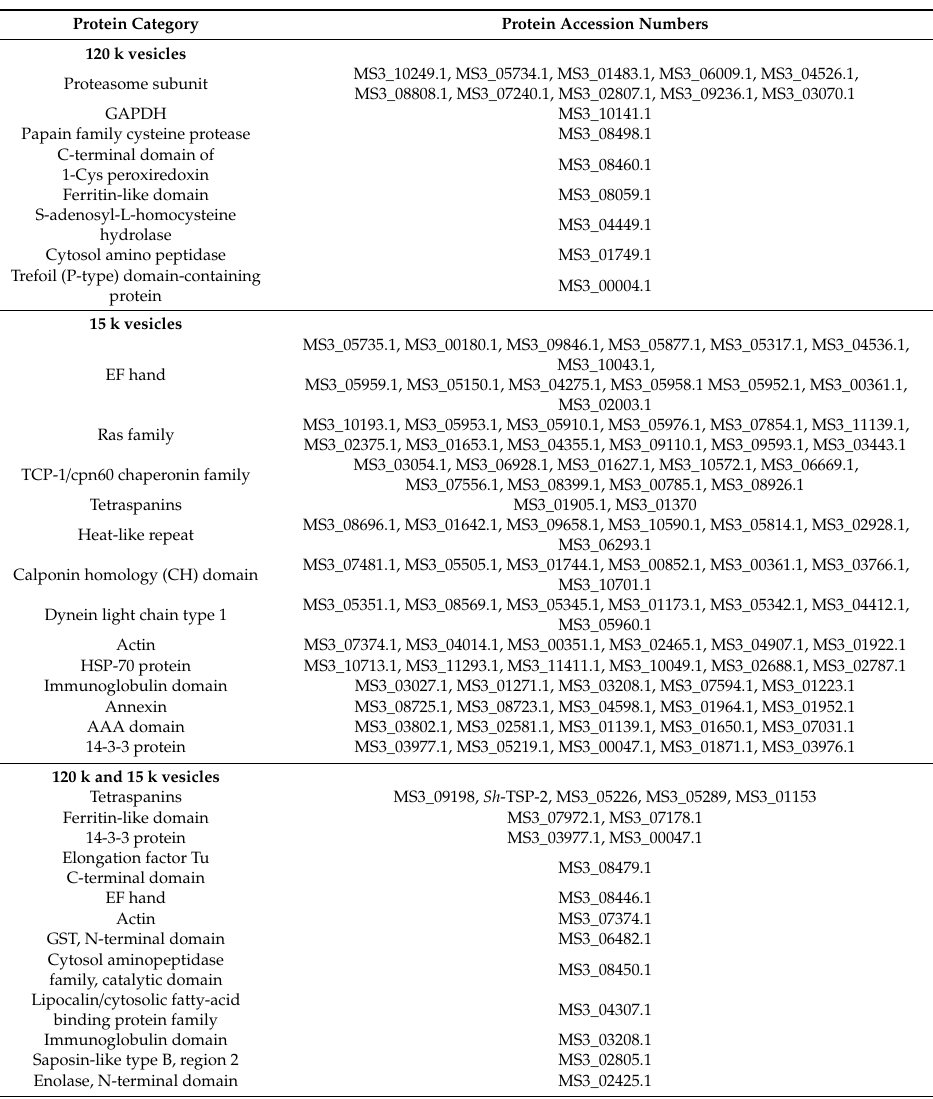
Table 1. Proteins found in 120 k and 15 k pellet vesicles isolated from the ES products of adult S. haematobium